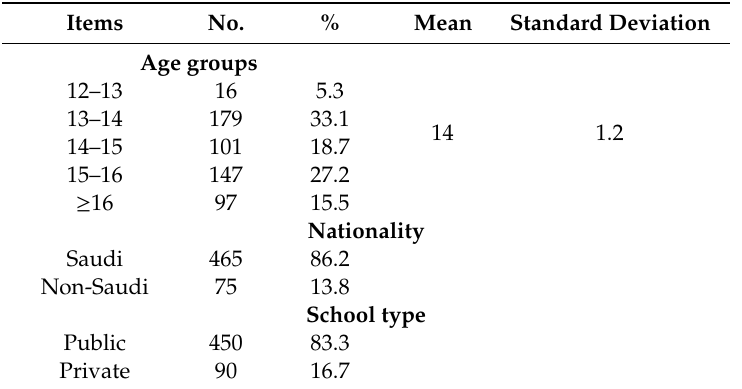
Figure 2. Causes of dental caries.